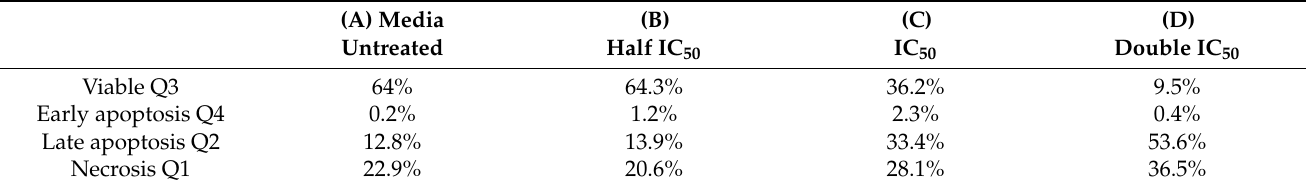
Table 5. Annexin V-staining FACS analysis of the hydroalcoholic extract of L. shawii .